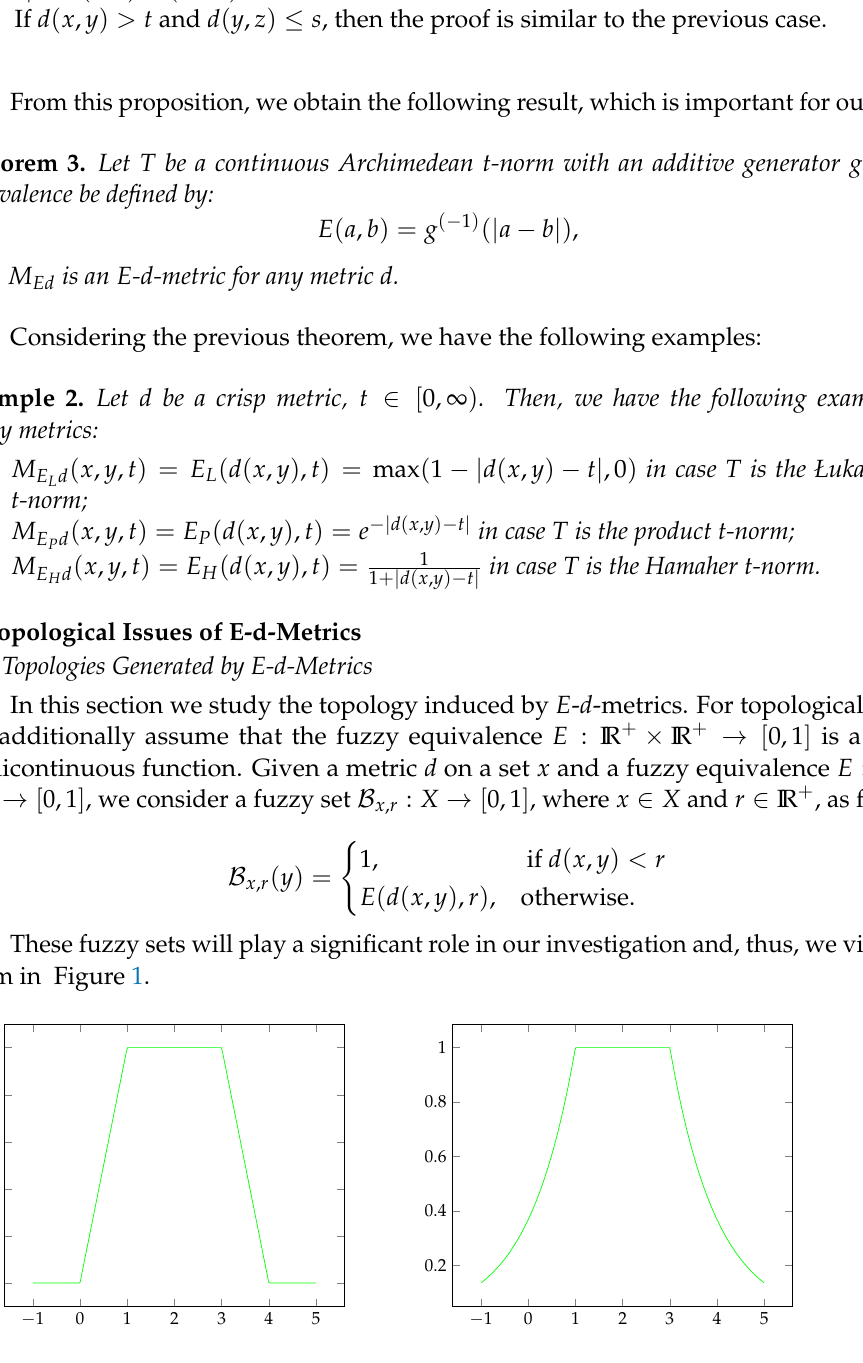
Figure 1. A figure demonstrates the fuzzy sets B x , r ( y ) , where X = IR, x = 2, r = 1, d ( x , y ) = | x − y | , E is the fuzzy equivalence relation with respect to the Łukasiewicz t-norm (on the left) and product t-norm (on the